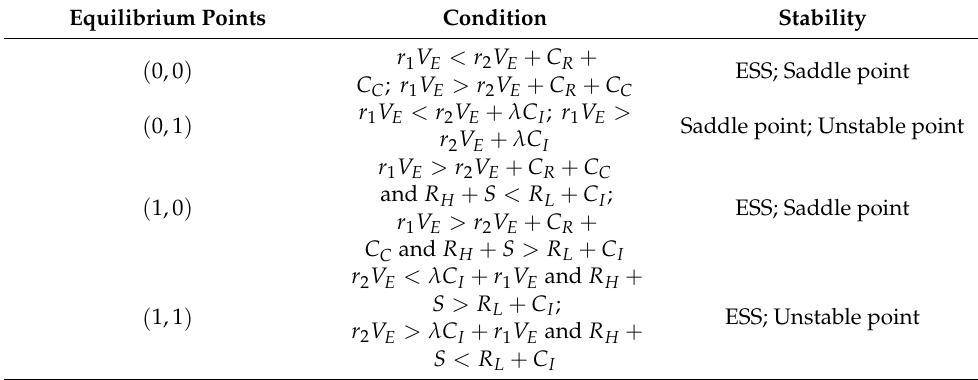
Table 3. Local stability analysis of equilibrium points of participation behavior. Equilibrium